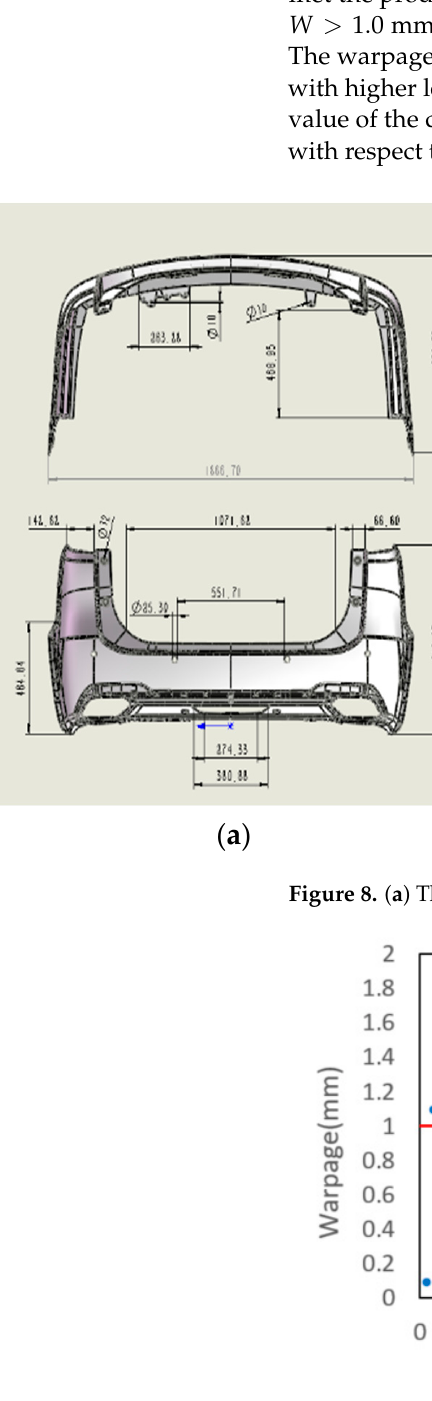
Figure 9. Classification of warpage of key length.